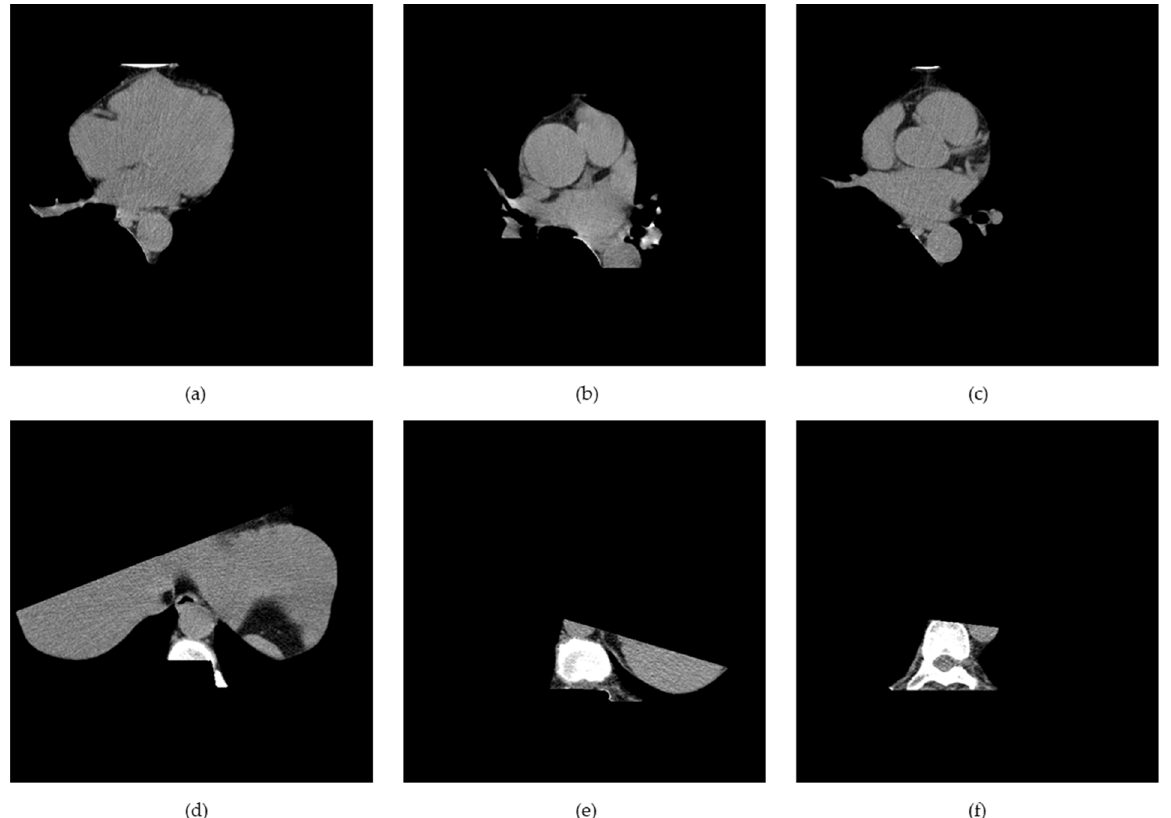
Figure 7. ( a – c ) Heart, and ( d – f ) non-heart, obtained through the cardiac region segmentation algorithm. Figure 8 shows the result of images created by dividing the data into nine segments using the cardiac region segmentation data. The image data divided into nine was resized